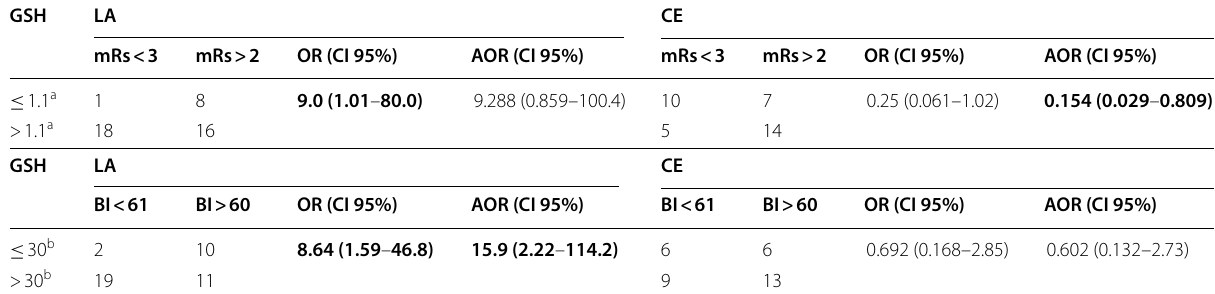
Table 4 Influence of t- and rGSH levels on the risk of poor functional outcome and dependence in daily care in stroke patients (21 days after